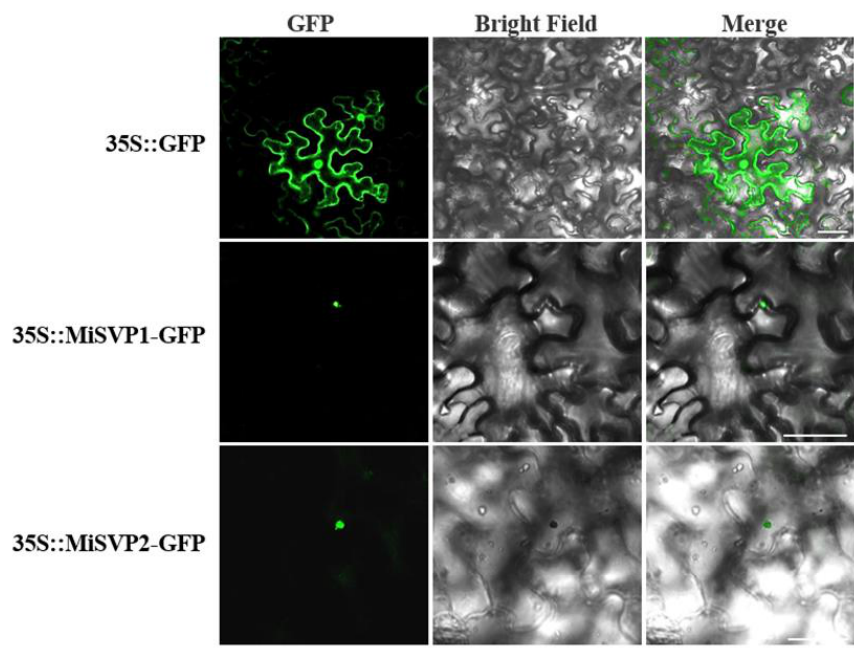
Figure 4. Subcellular localization of MiSVPs in tobacco leaves. GFP: Signaling of a GFP-fused protein by fluorescence microscopy; Merged: superimposed GFP and bright-field images. Bars = 50 μm.